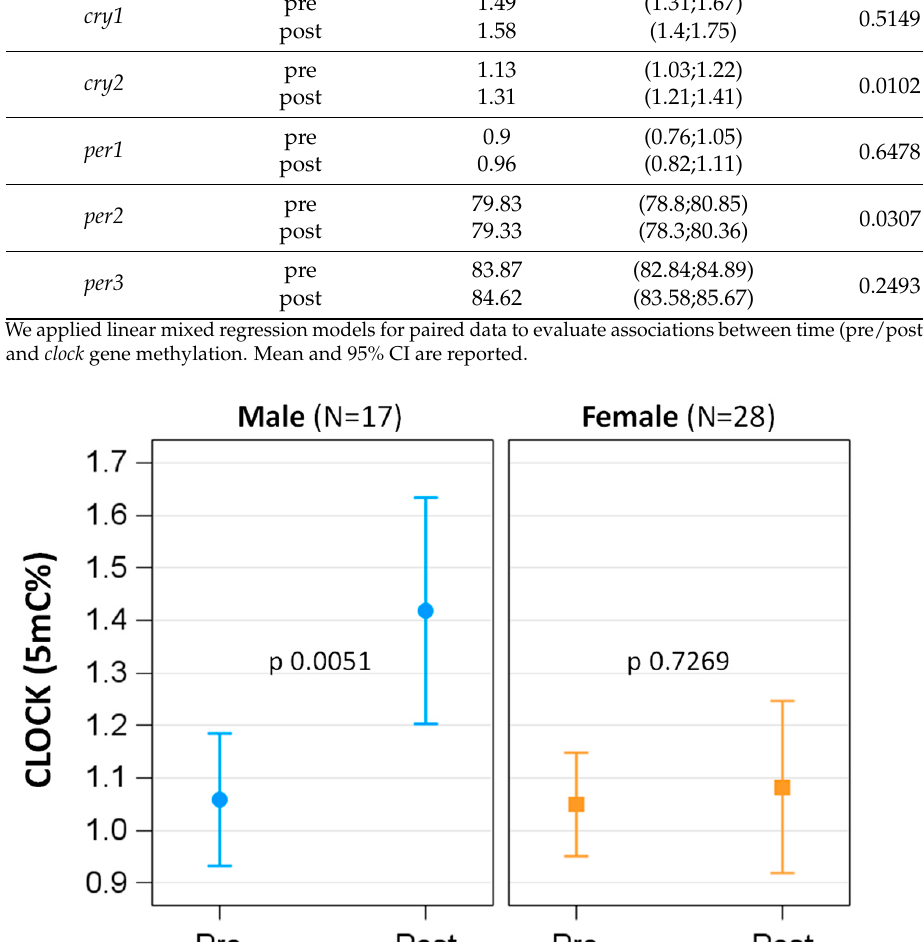
Table 4. Demographic, lifestyle, biochemical and clinical characteristics of study participants: pre- vs. post-BWRP comparison in subjects with (MetS+) or without (MetS-) metabolic syndrome.